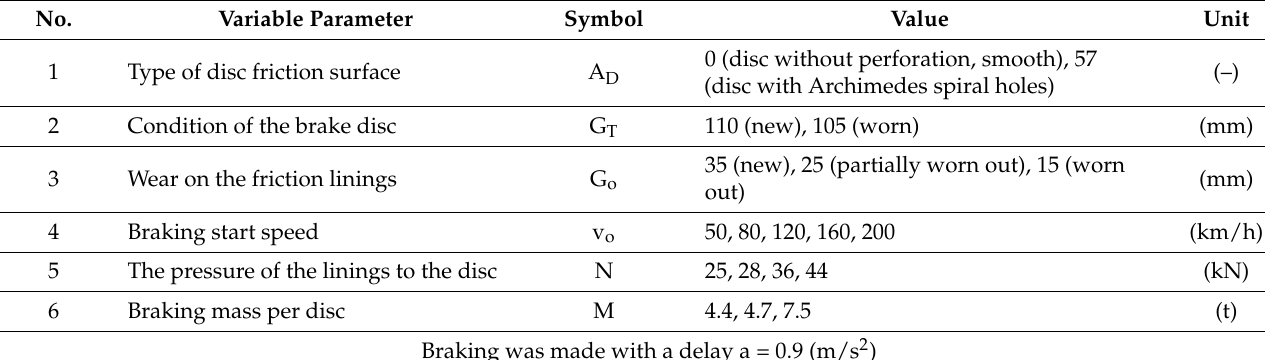
Table 1. Program of the bench